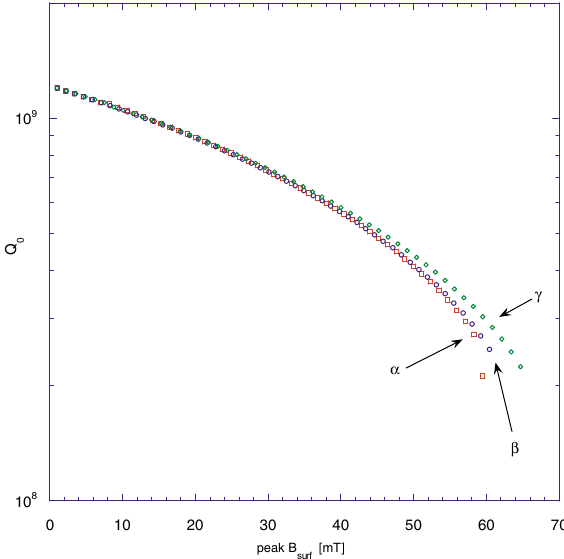
FIG. 7. (Color) Simulation of a TRASCO 700 MHz cavity at 4.2 K with pipe cooling. The cavity surface coverage is 20% for all curves. Curve ( (cid:7) ): 3 pipes ; (cid:3) 1 : 8 cm ; curve ( (cid:11) ): 5 pipes ; (cid:3) 1 : 0 cm ; curve ( % ): 9 pipes ; (cid:3) 0 : 7 cm